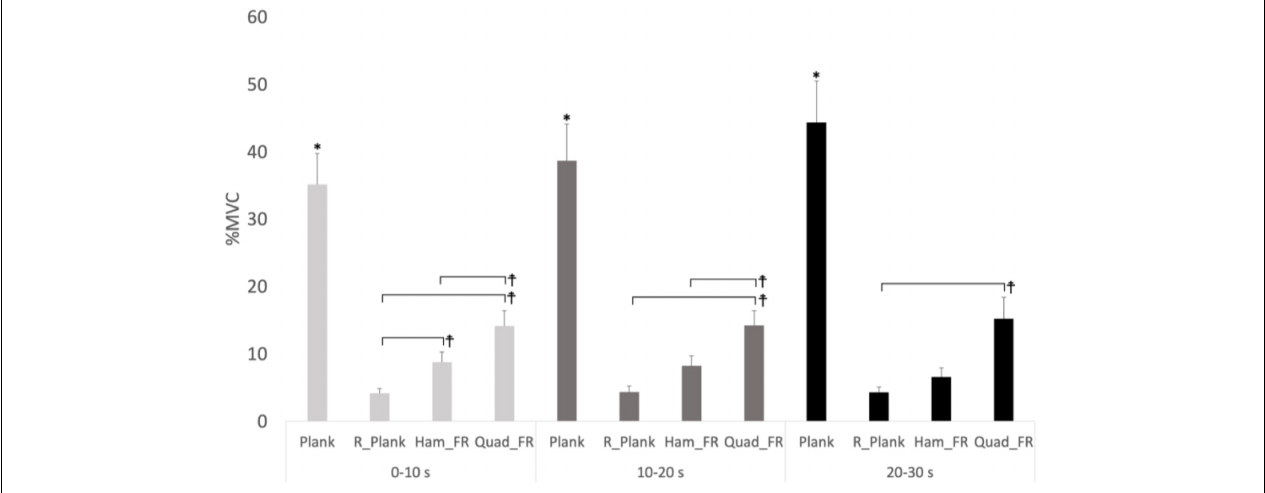
FIGURE 4 | Time*Condition interaction with external oblique muscle EMG activity. ∗ Significance difference between plank with reverse plank, hamstrings foam rolling and quadriceps foam rolling ( p < 0.05). ∗ Significant difference between the conditions ( p < 0.05), %MVIC refers to MVICmax. R_Plank, reverse plank; Ham_FR, hamstrings foam rolling; Quads_FR, quadriceps foam rolling groups. The symbol “ ‡ ” represents a significant difference between the two conditions (exercises) illustrated by the horizontal lines.